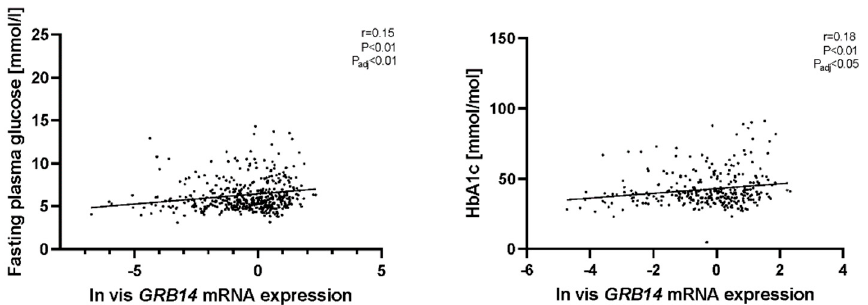
Figure 4. Correlation between vis AT GRB14 mRNA expression glucose variables. The correlation of natural log transformed vis GRB14 mRNA levels with fasting plasma glucose ( n = 473) and glycated haemoglobin (HbA1c) ( n = 309) is shown. Pearson correlation coefficients and corresponding p -value have been included; p adj : adjusted by BMI, age, and sex; vis: visceral adipose